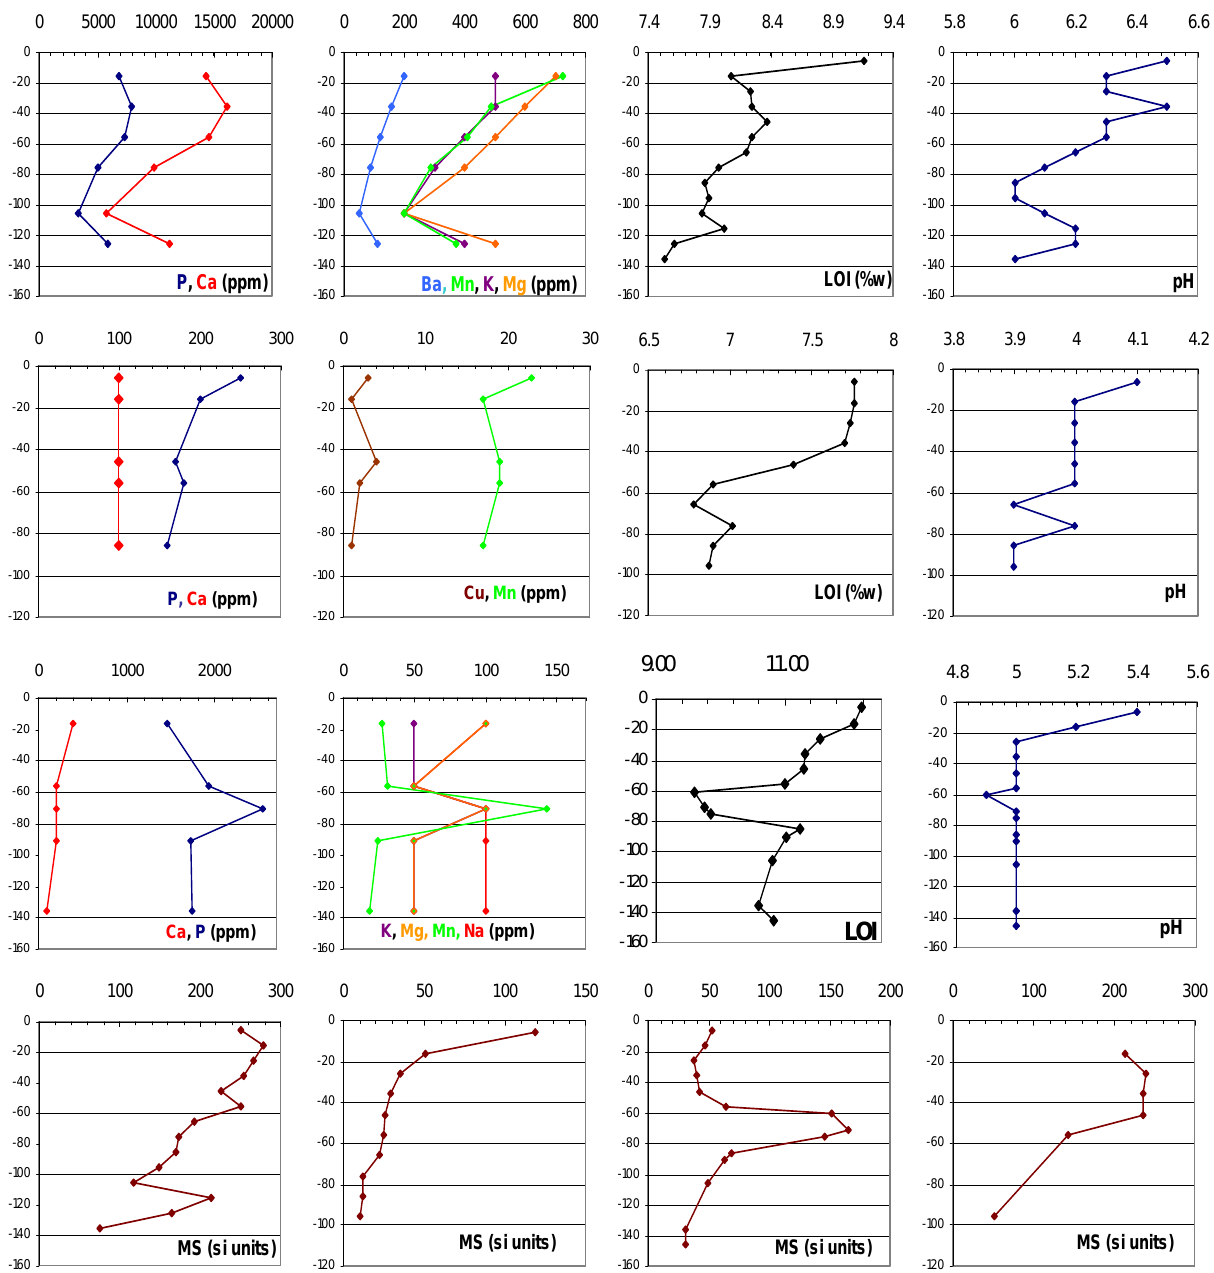
Figure 6. Rows 1-3: total elemental concentrations (measured by ICP-AES), carbon estimates (LOI, 550C), and pH (1:2 solution) plotted by depth. Row 1: Hatahara terra preta (Figure 4a). Inflection in lower part of the profile is at the same depth as an early 1 st millennium AD occupation. Row 2: Yellow Latosol profile (Figure 4b) with sub-recent burning, same landform as Hatahara terra preta profile. Row 3: Terra mulata buried horizon at Lago Grande (Figure 4c). Row 4: Magnetic susceptibility values (Low frequency Tesla units, measured with a dual frequency Bartington MS2/MS2B sensor). From left to right: each of the previous three profiles and (bottom right) exposed terra mulata at the Lago Grande site (Figure